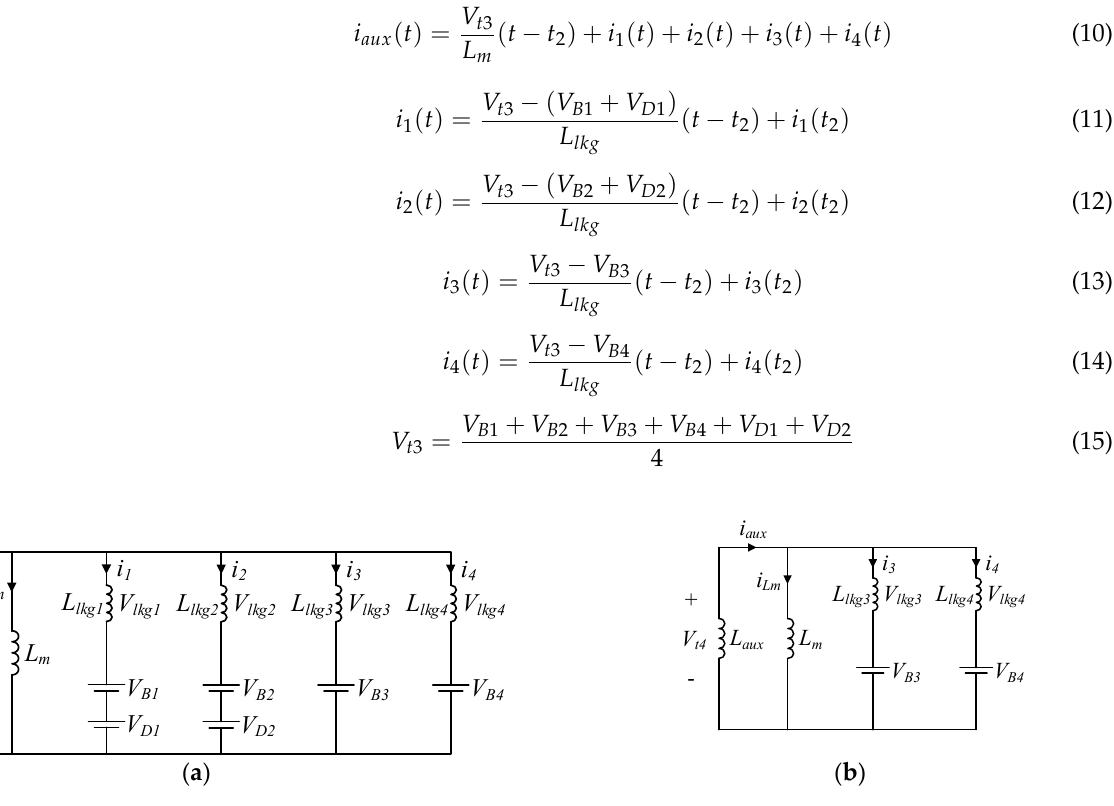
Figure 9. Equivalent circuits of the proposed circuit: ( a ) mode 3 and ( b ) mode 4.